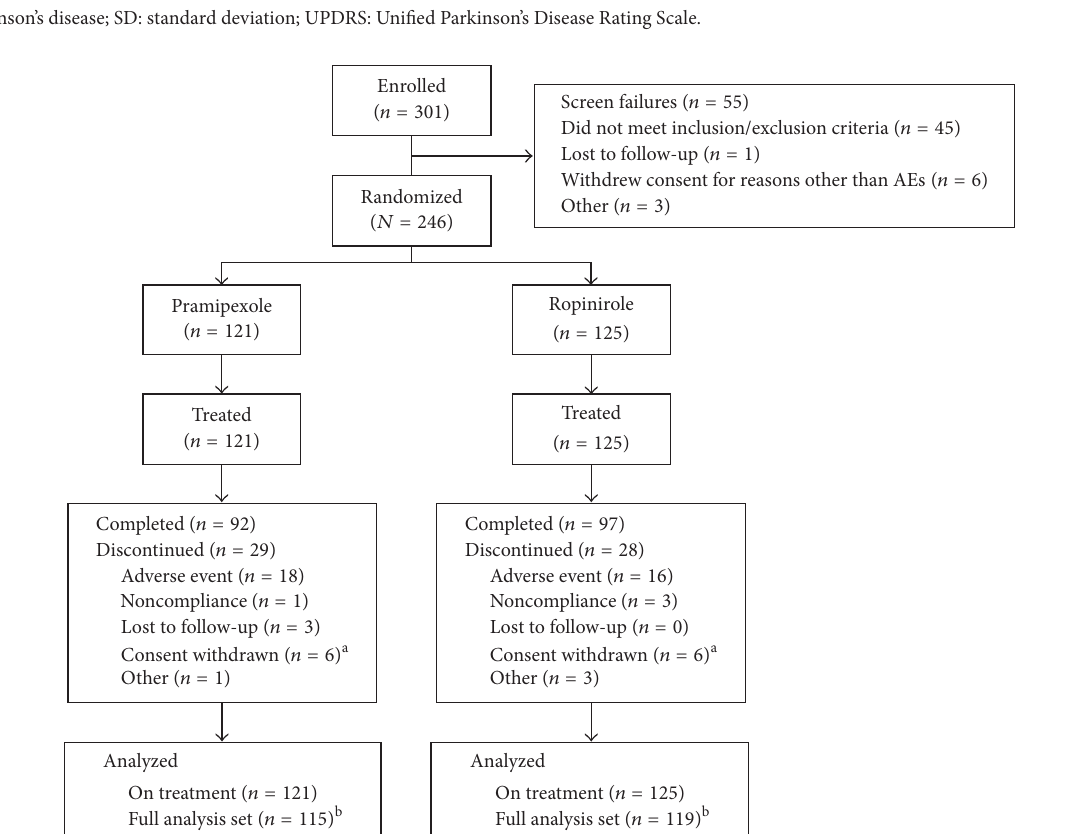
On treatment (n = 125) Full analysis set (n = 119) b Figure 1: Subject disposition. Among the 55 patients who failed screening, 45 did not meet inclusion/exclusion criteria, 1 was lost to follow- up, 6 withdrew consent (for reasons not involving adverse events), and 3 had other reasons. a For reasons other than adverse events. b The FAS includes all patients from the treated set who had a baseline and at least 1 postbaseline comprehensive ophthalmology assessment (COA). AE: adverse event and FA: full analysis